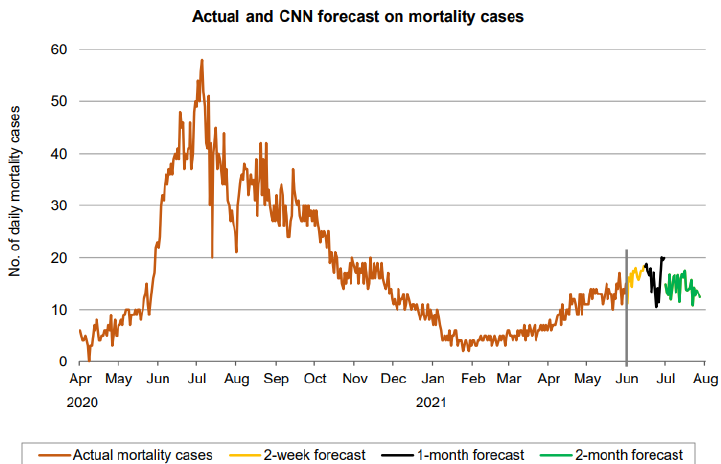
Figure 19. Prediction over a 60-day forecast for the death cases using the CNN model.